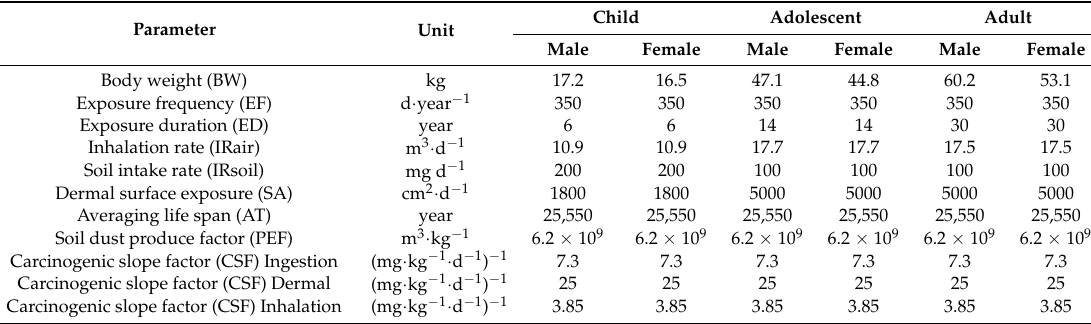
Table 1. Parameters used in the incremental lifetime cancer risk